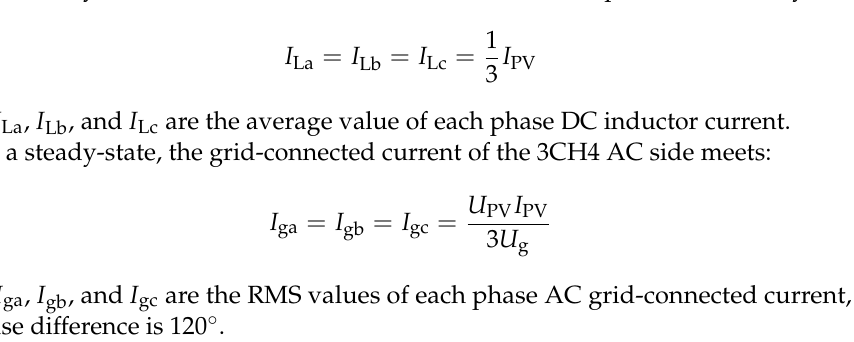
Figure 6. Block diagram of CL filter. In Equations (11) and (12), the current loop transfer function G i ( s ) and equivalent im- pedance Z g ( s ) can also be obtained: ()() () ()() () 